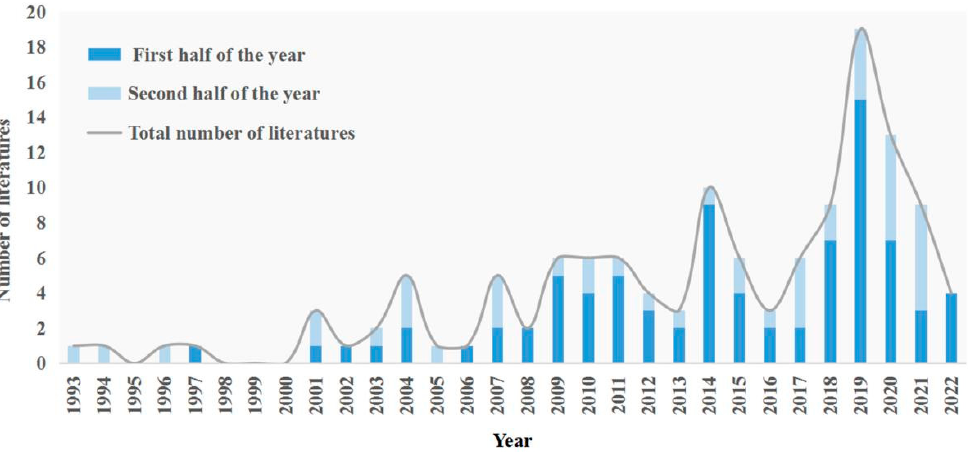
Figure 4. Annual distribution of the literature.